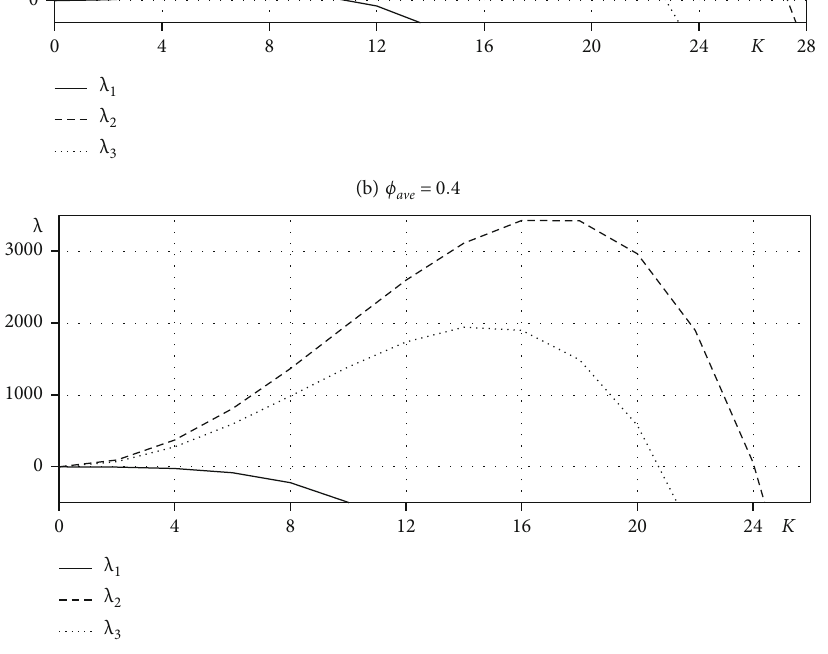
Figure 3: Analytic growth rates of the CH equations for di ff erent free energy functions F ϕ = 0 : 6 ave